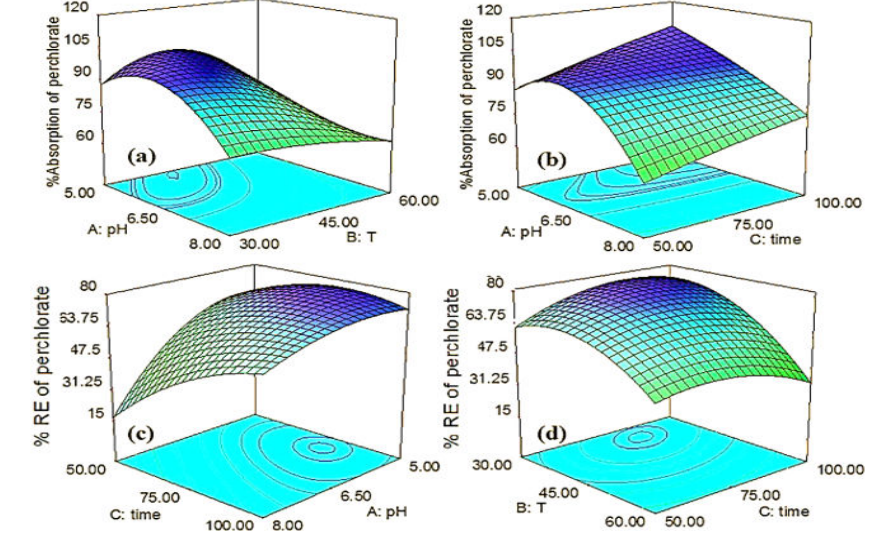
Fig. 5. Response surface graph of the variation of the adsorption efficiency, (a) function of the initial pH and temperature (time = 86.56 min), (b) function of time and pH (T=33.94 °C). (c) function of the initial pH and time (T= 33.94 °C), (d) function of time and temperature (pH